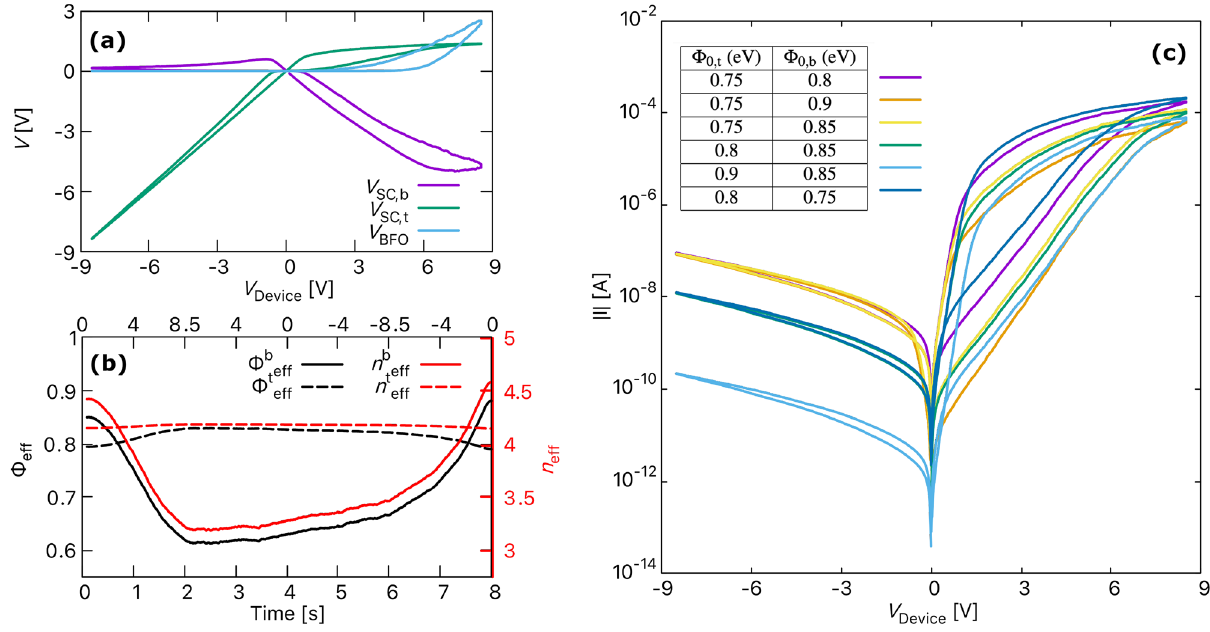
Figure 5. ( a ) Voltage drop across different regions of the BFO memristor. ( b ) The change in top and bottom effective Schottky barrier heights ( (cid:31) eff ) and effective ideality ( n eff ) factor as a function of time. ( c ) The simulated I – V curves showing the effect of top and bottom Schottky barrier height on the set and reset process. Curves with (cid:31) 0,t =0.8 eV overlap in the negative bias region.